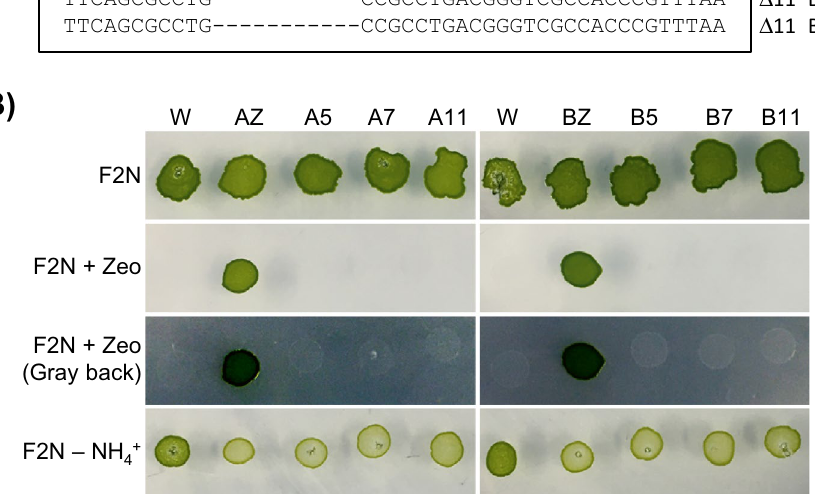
Figure 3. Verification of gene edited Nannochloropsis oceanica strains with vector removal. ( A ) NoNR target site sequences of strains with potential all-in-one NoNR PtTALEN-ARS plasmids removal. To rule out contamination with wild-type cells, the NoNR target site sequencing of potentially plasmid removed strains was performed. WT: Wild-type genomic DNAs; AZ and BZ: total DNAs from a single colony of N. oceanica that emerged in a selectable plate following introduction of all-in-one NoNR PtTALEN-ARS plasmids; A5, A7 and A11: total DNAs of clearance treated cells of AZ; B1, B2 and B3: total DNAs of clearance treated cells of BZ. Underlined sequences of WT strain indicate the TALEN binding sites. Dashes indicate deletions. ( B ) Verification of all-in-one PtTALEN-ARS vector clearance by phenotypic analysis using spot tests. Wild-type, TALEN strains, or potentially plasmid-removed strains were cultured with 2 mL F2N liquid medium, and 5 µL (3.6 × 10 4 cells µL −1 ) of resultant cultures were spotted onto solid plates. Because the spots of zeocin sensitive strains could not be seen on the F2N + Zeo plate in the picture with a white background, the F2N + Zeo plate pictures with a gray background are presented to show the spot marks. F2N: F2N plate; F2N + Zeo: F2N